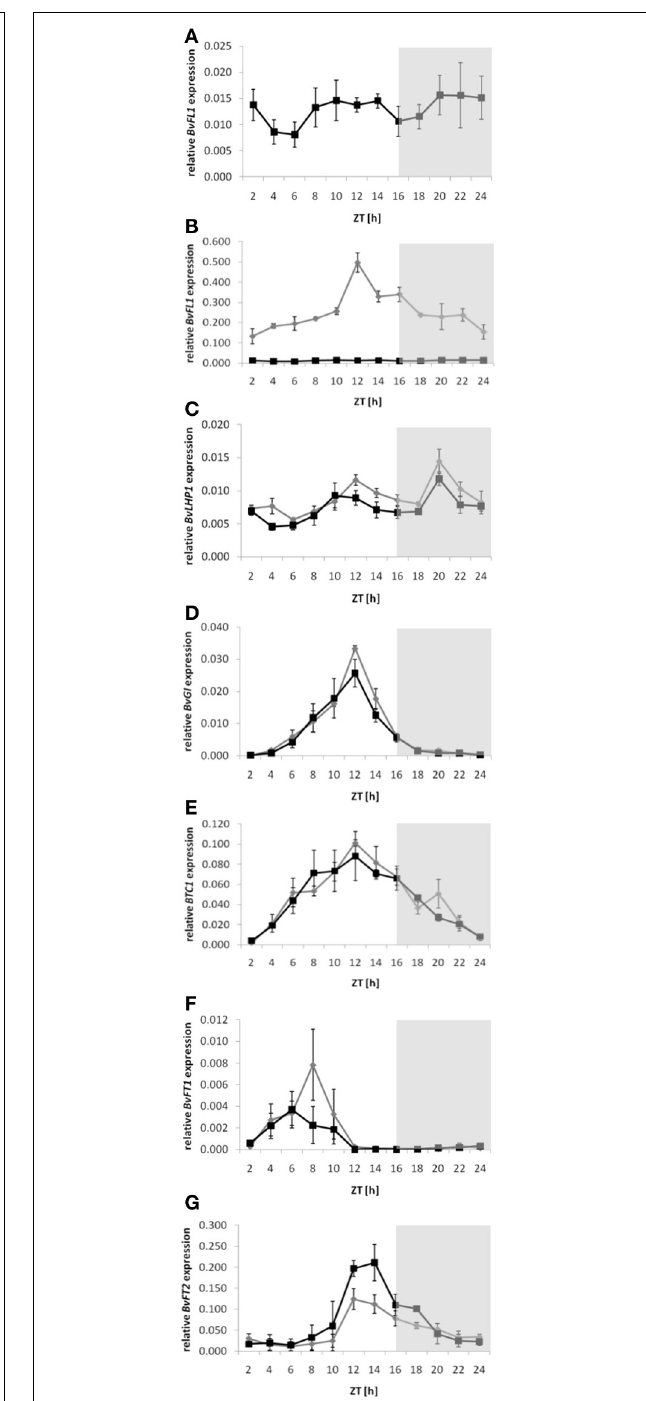
FIGURE 4 | Diurnal expression profiles of floral regulator genes or candidate genes in BvFL1 over-expressing plants. Expression in the BvFL1 over-expressing transgenic event 016-05C (gray line and diamonds) and the biennial control genotype (black line and squares) was determined 4 weeks after the end of vernalization under long-day conditions. (A,B) BvFL1 , (C) BvLHP1 , (D) BvGI , (E) BTC1 , (F) BvFT1 , and (G) BvFT2 . Expression analysis and normalization was performed as described for Figure 1